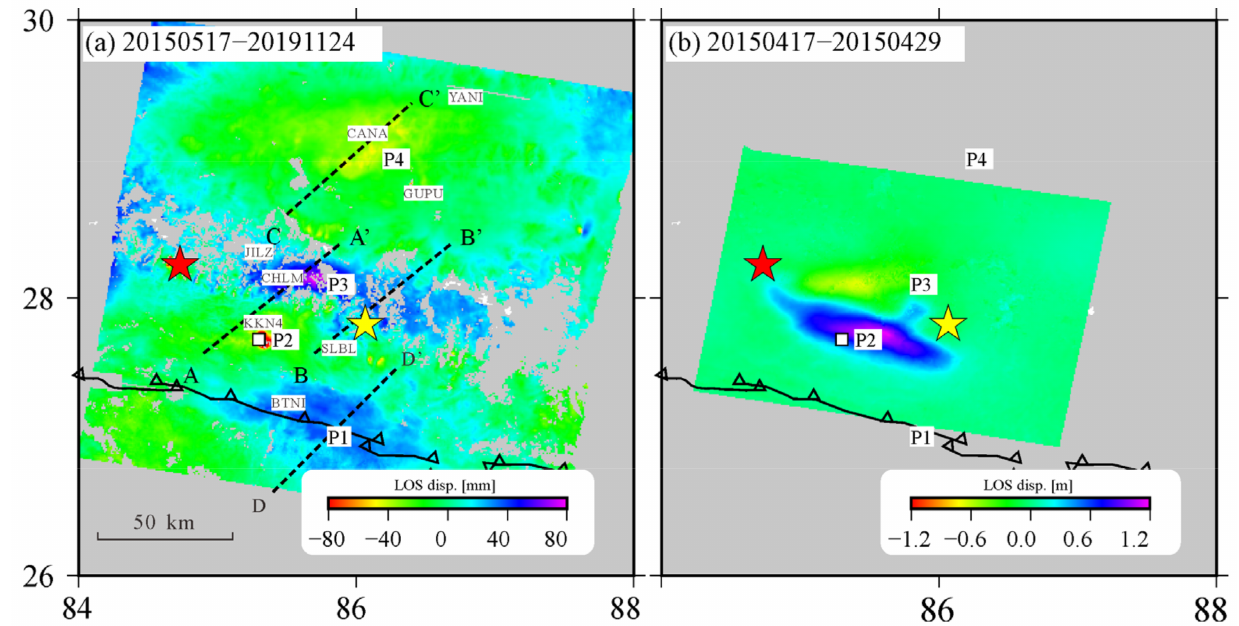
Figure 5. Comparison of post-seismic and co-seismic deformation fields of the Nepal Mw 7.8 earthquake, ( a ) The post-seismic deformation of ALOS-2 descending data in 4.5yr, ( b ) co-seismic deformation field from ALOS-2 data, the black straight dashed line indicates the location of the profile; the red star represents the epicenter of the Mw 7.8 earthquake, the yellow star represents that of the Mw 7.3 earthquake; Curves with triangles indicate the MFT, the white square shows the location of